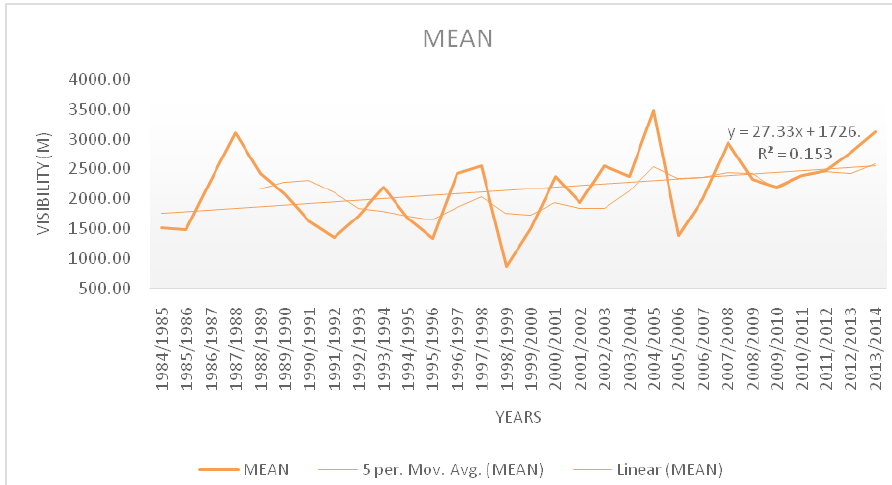
Figure 6: Seasonal mean distribution and trend of visibility for Nguru (1984-2014).